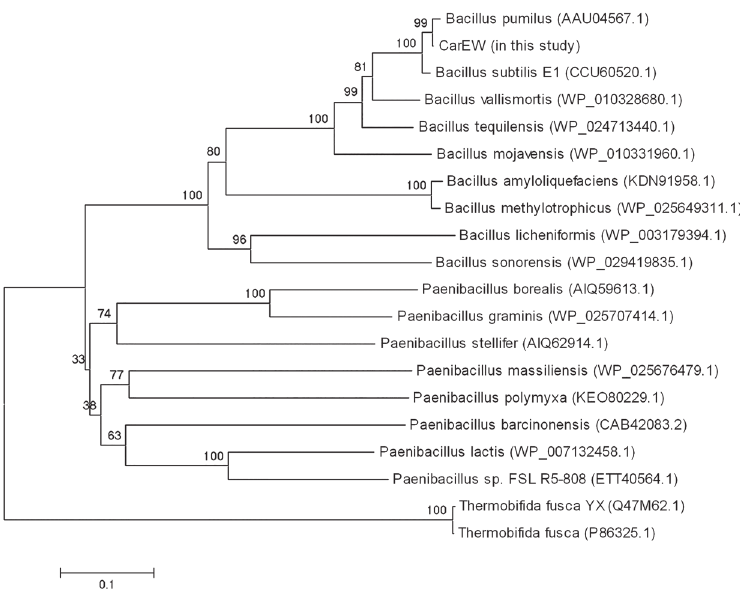
Fig 2. Neighbor-joining tree of esterases. Protein sequences were aligned using the built-in CLUSTAL W (default parameters), the tree was built using the neighbor-joining method with default parameters and 1000 bootstrap